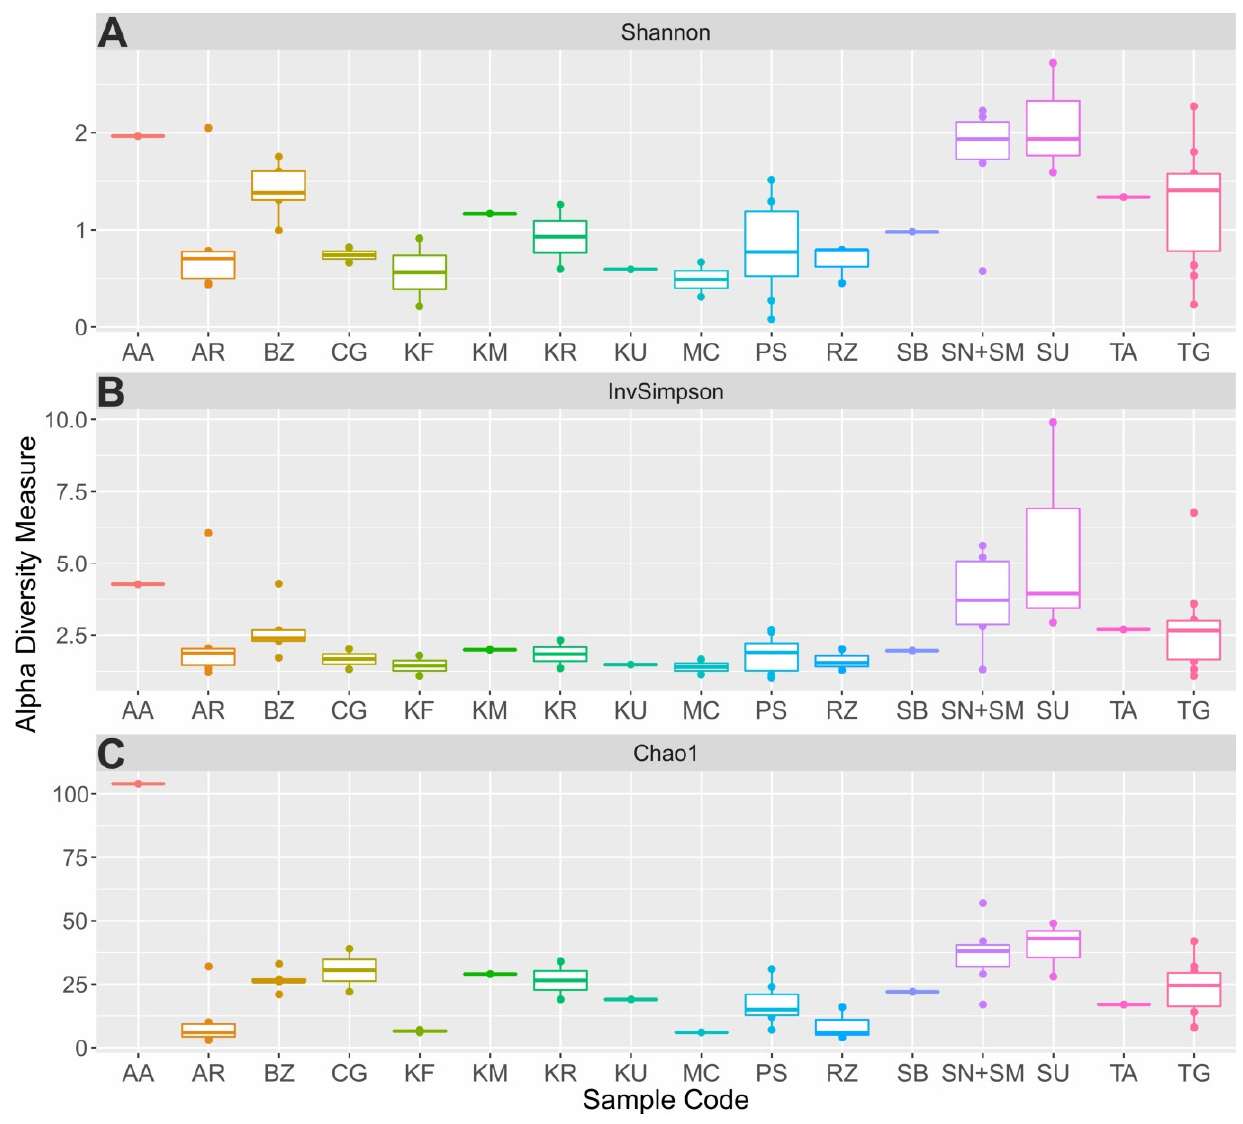
Figure 4. Alpha-diversity metrics of fermented milk products. Calculated values of the Shannon ( A ), inverse Simpson ( B ) diversity indexes and Chao1 richness estimator ( C ) are presented for the aarts (AA), ayran (AR), bryndza (BZ), chegen (CG), kefir (KF), koumiss (KM), khurunga (KR), khuruud (KU), matsoni-like product (MC), prostokvasha (PS), ryazhenka (RZ), shubat (SB), sour cream (SN+SM), suluguni-like cheese (SU), tan (TA) and cottage cheese (TG) samples. P-values representing the significance of differences found in alpha-diversity metrics were 0.00681, 0.104 and 2.99e-08, respectively.